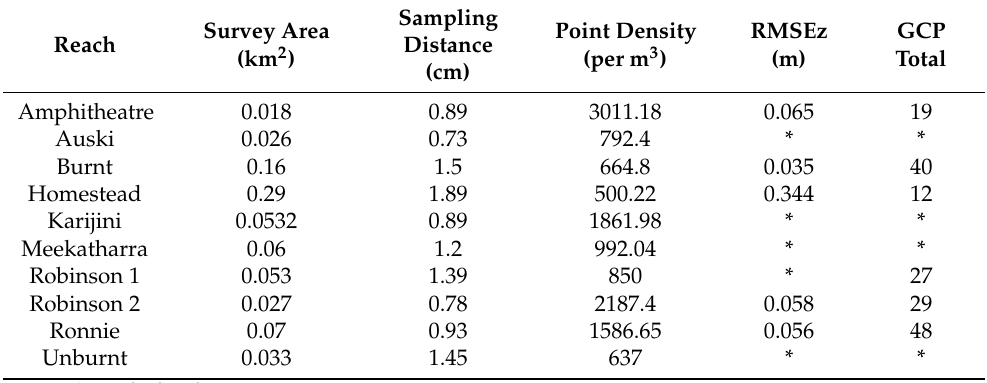
Table 2. SfM survey accuracy for catchments.